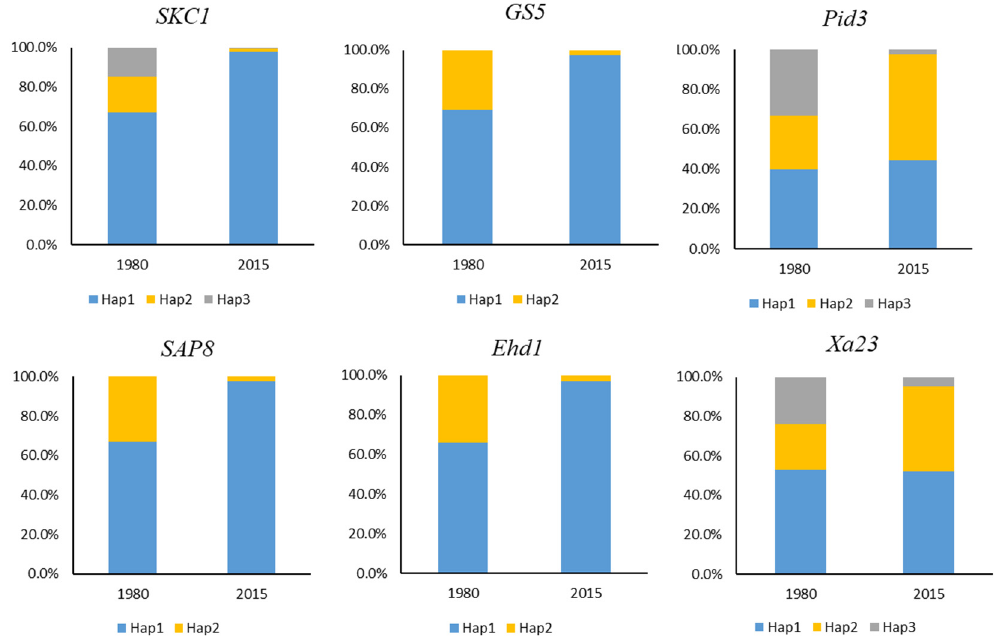
Figure 7. Changes in the haplotype frequency in a set of rice accessions collected in 1980 and 2015. The circle size is proportional to the quantity of samples within a given haplotype, and the numbers next to the circle represent the haplotype type. Lines between different haplotypes represent the mutational steps between alleles. When more than one nucleotide difference existed between two linked haplotypes, the number of differences is shown next to the line. Yellow represents landraces collected in 1980, and pink represents landraces collected in 2015.